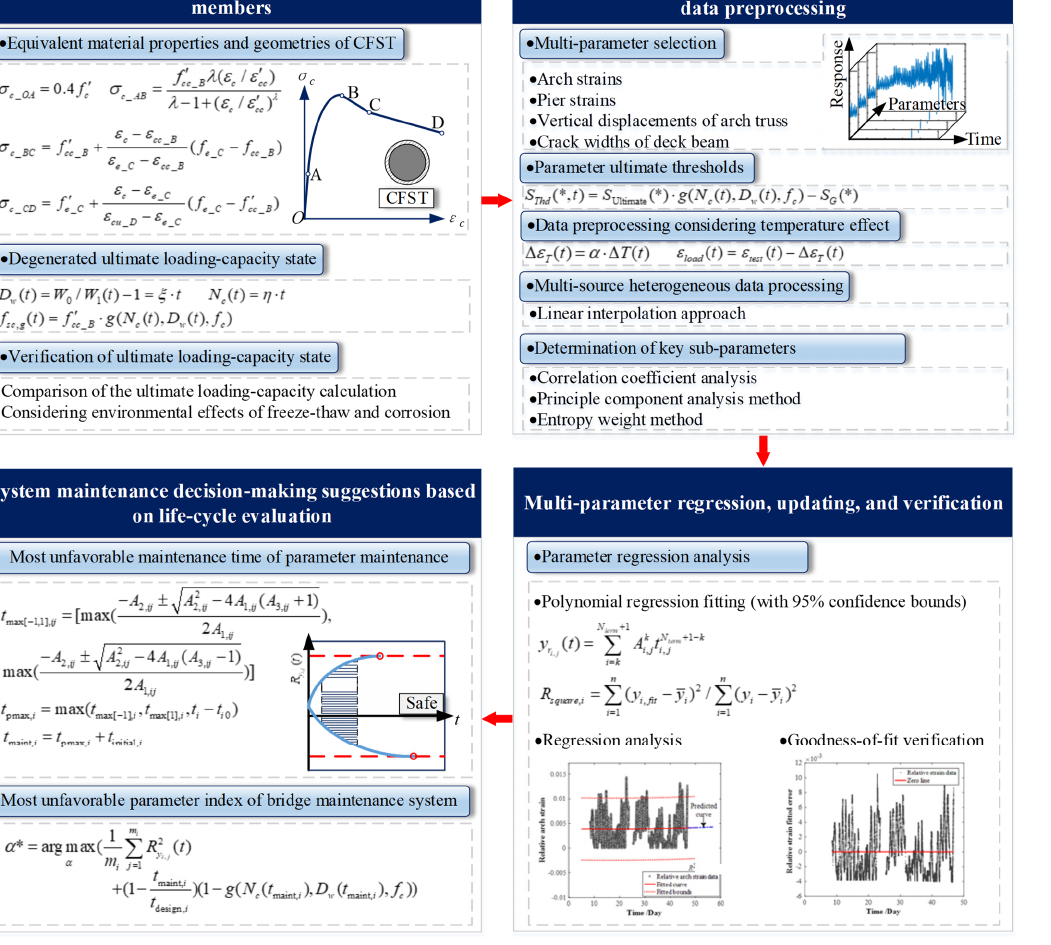
Figure 1. Procedure of life-cycle performance evaluation for CFST bridges.